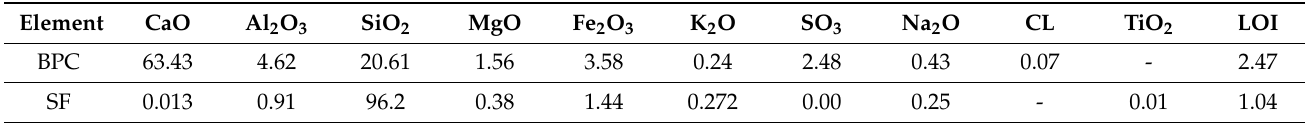
Table 1. Physical and chemical properties of BPC and